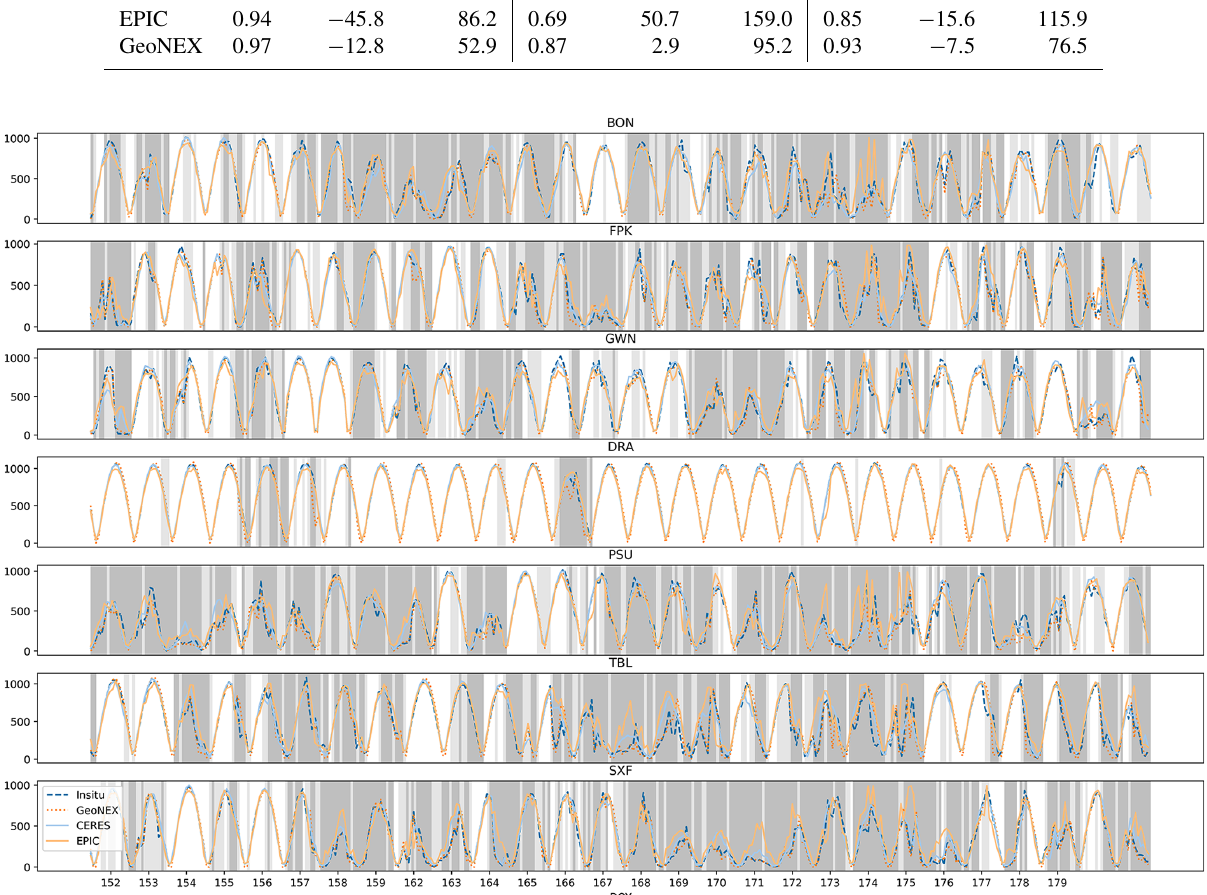
Figure 7. The diurnal cycles of GeoNEX, EPIC, and CERES estimations compared with in situ measurements at seven SURFRAD sites in June 2018. Cloudy conditions are marked in dark grey, and partially cloudy conditions are in light